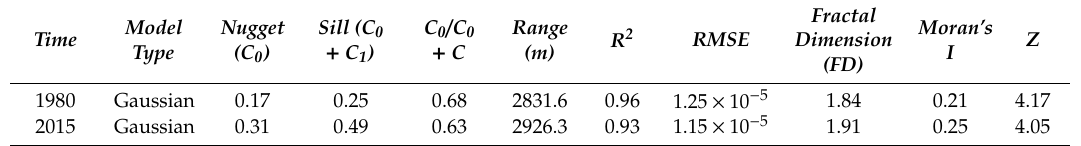
Table 5. Semivariogram model of SOCD and its parameter values.